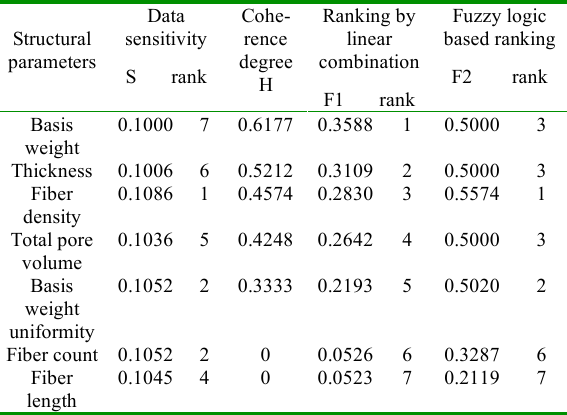
Table 2. Ranking of the structural parameters according to their relevancy to water permeability.